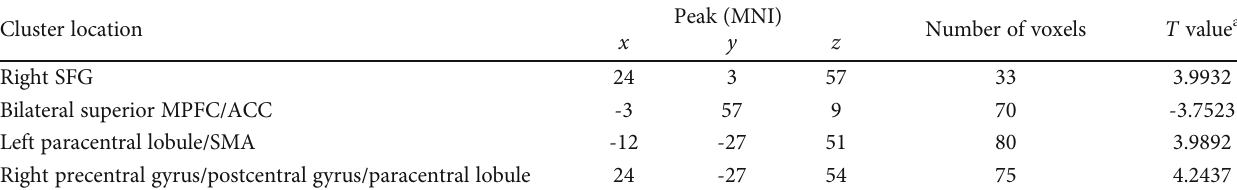
Table 2: Regions with abnormal GFC in the patients.